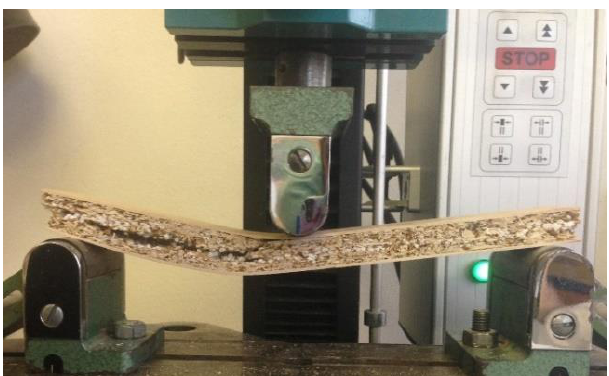
Figure 5. Delamination of the samples under bending strength test.